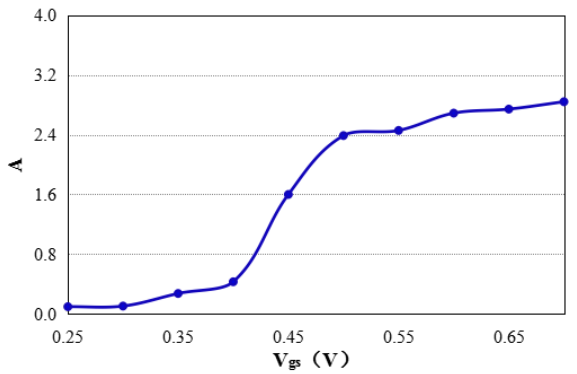
Figure 5. The value of 1/(1 + C gs / C gd ) against V gs .